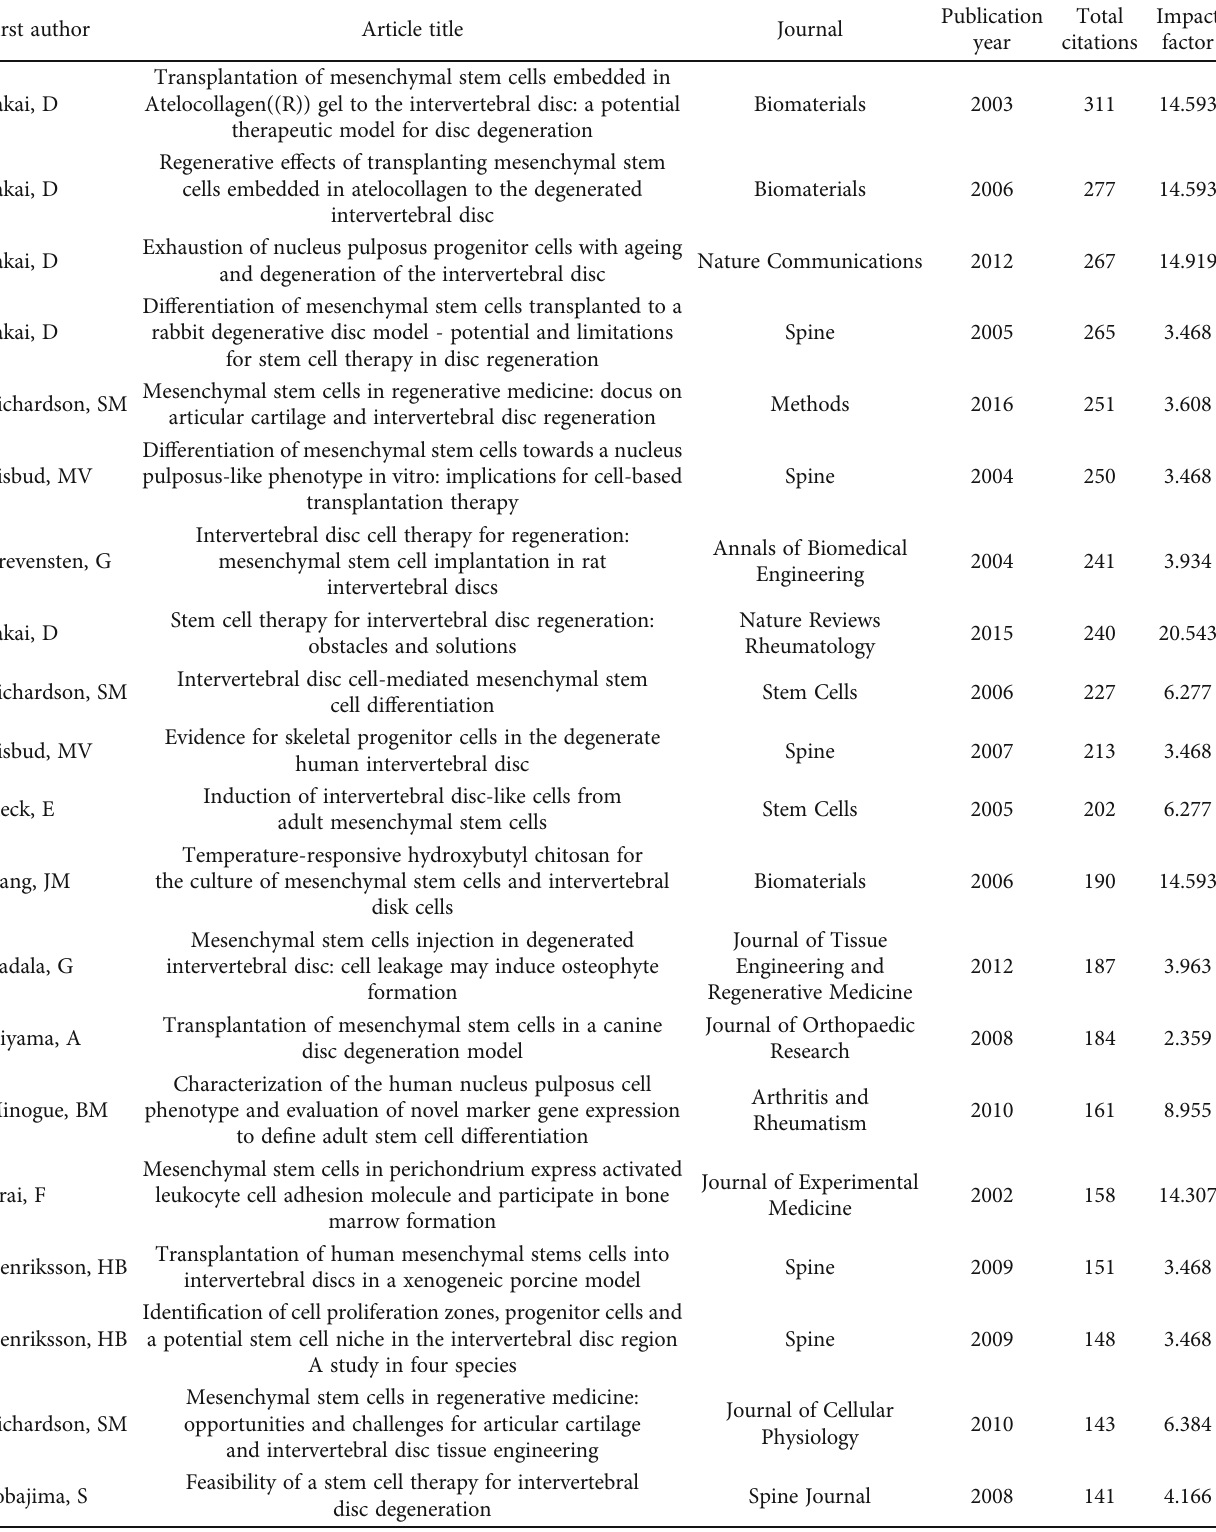
Table 1: Top 20 most cited articles on stem and progenitor cells in intervertebral